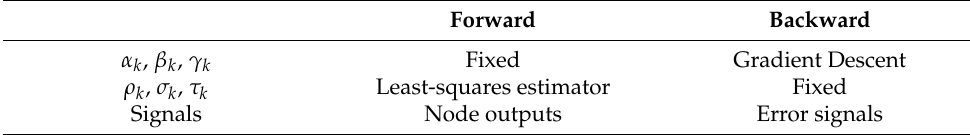
Table 1. The hybrid learning methodology for ANFIS.